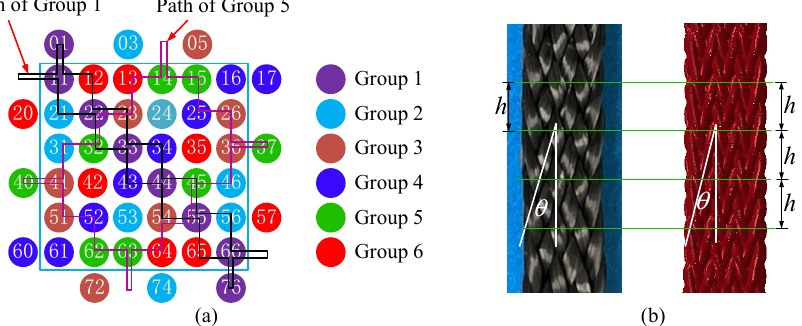
The count of carriers in the rectangle pattern is determined by the row and column number of yarns of the main part [ m × n ] , which is given as, N = mn + m + n (1) where m and n are the row and column yarn numbers in the main part, respectively, and N is the total number of yarns. After 4 N / t steps, all carriers return to the original position, where t denotes the greatest common divisor of m and n . Figure 1. Schematic of the 3D four-directional braiding process: ( a ) the original arrangement, ( b ) the braiding machine [27]. Reprinted with permission from [27]. Copyright 2020, The Regenerative Engineering Society. ( c ) Step 1, ( d ) Step 2, ( e ) Step 3, and ( f ) Step 4.